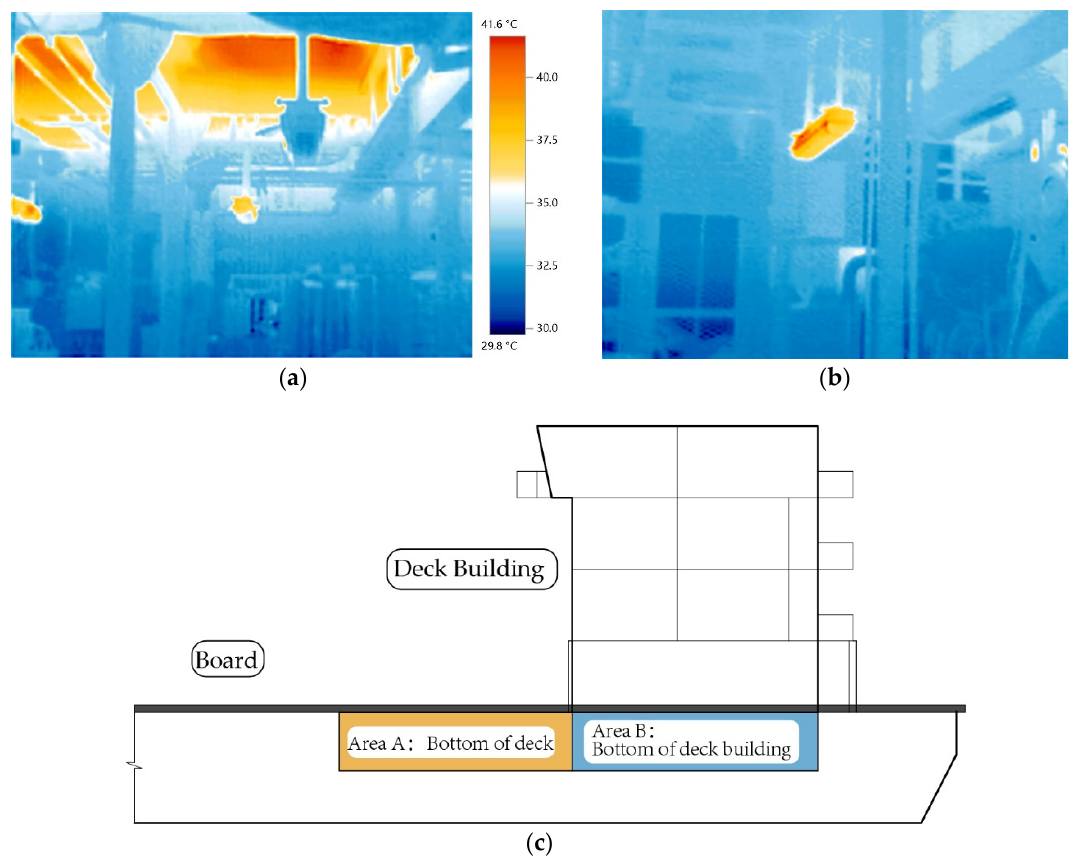
Figure 24. Thermal images of the ship’s structure. ( a ) Bottom of deck, ( b ) Bottom of deck building, ( c ) Diagram of the thermal imaging area.